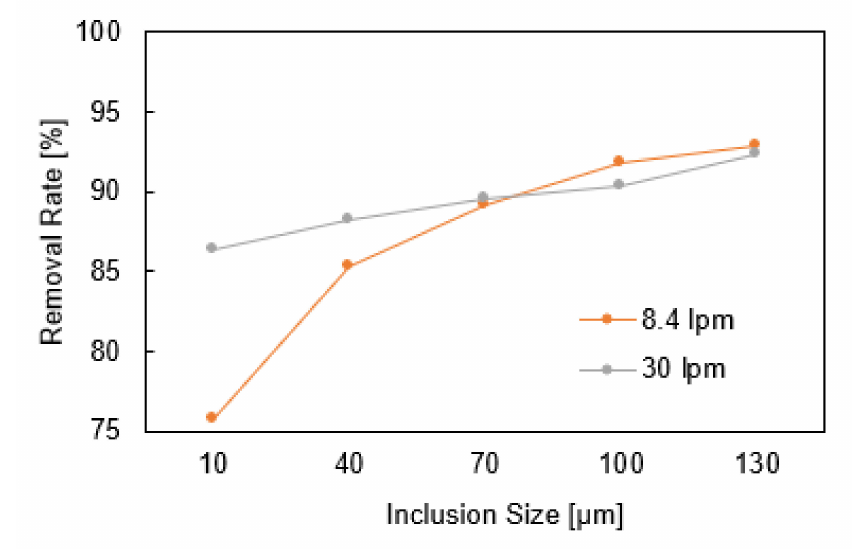
Figure 11. The e ff ect of the gas flow rate on the inclusion removal rate (inclusion density: 3500 kg m − 3 , Case 3-W + LD +